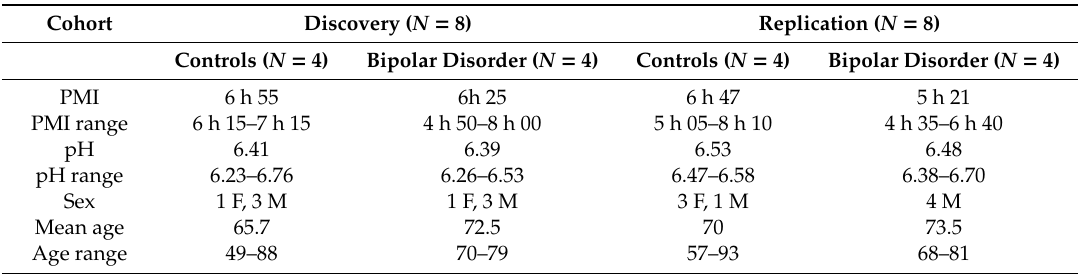
Table 1. Baseline characteristics of the study population. PMI = postmortem interval. M = male. F =